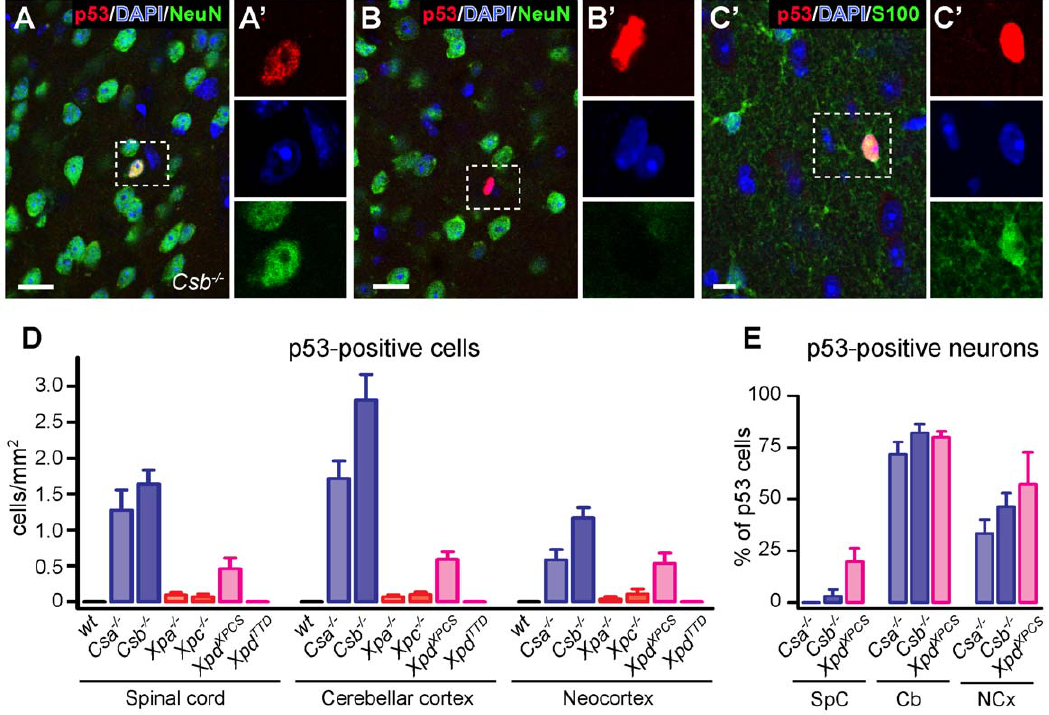
Figure 1. p53 expression in brain and spinal cord of adult NER– and TCR–deficient mice. A–C) Double-labeling confocal images showing p53-NeuN (A, B) and p53-S100 (C) double-labeled cells in neocortex of a 25 week old Csb 2 / 2 mouse. Scale bars: 25 m m (A, B) and 10 m m (C). D, E) Bar graphs showing the density ofp53-labeled cells, andthe relative amount ofp53-neurons (i.e. percentage ofNeuN-positivep53-labeled).Values aremeans 6 SE of 3 or 4 mice, while value per mouse is based on analysis of 4 (neocortex [NCx], cerebellar cortex [Cb]) or 10 (lumbar L4 spinal cord [SpC])